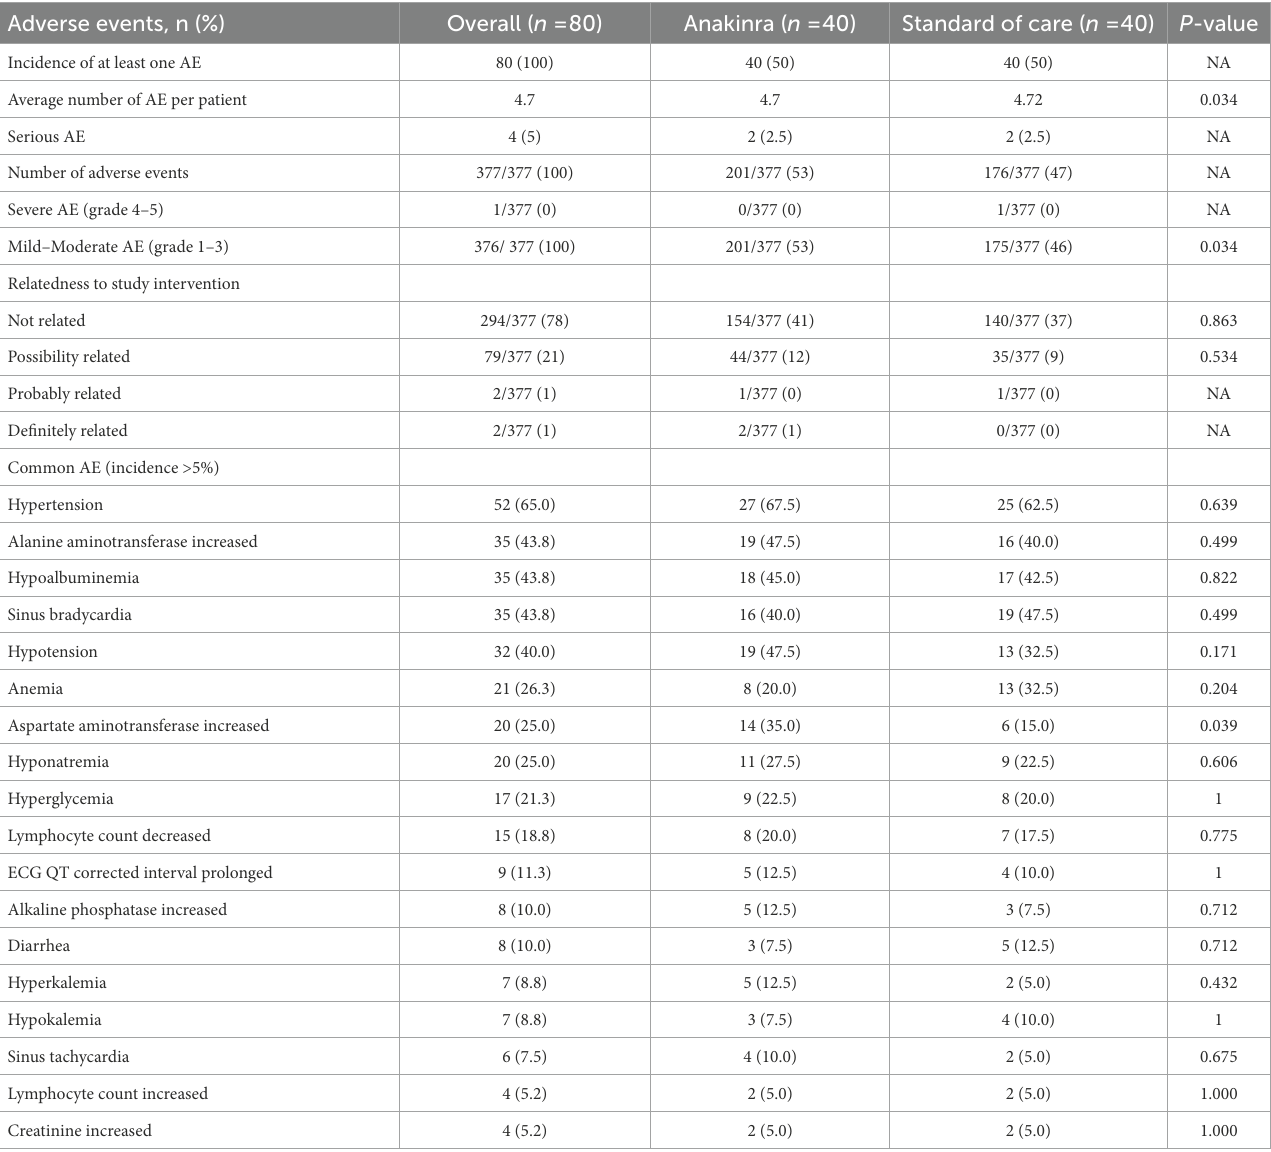
TABLE 3 Reported adverse events for study